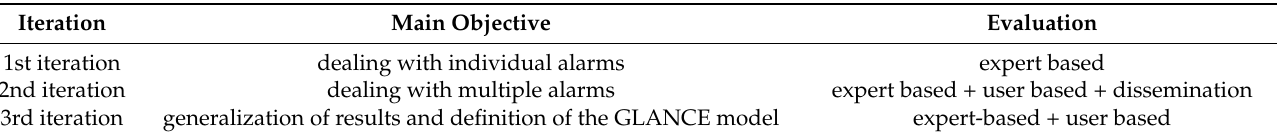
Table 3. Overall project